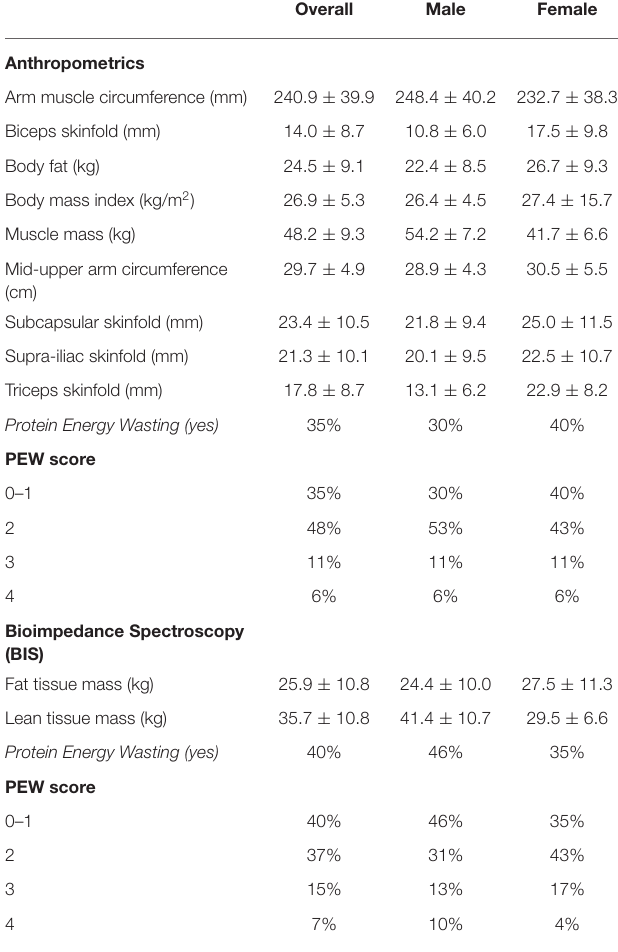
TABLE 2 | Nutritional parameters at baseline.